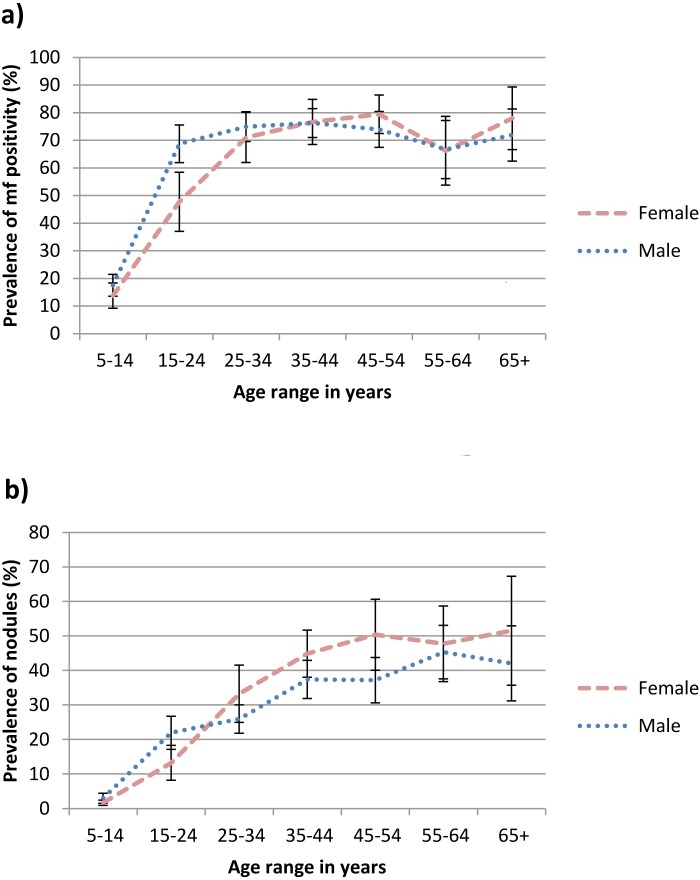
Age and gender-specific prevalence of a) microfilarial positivity and b) nodules in endemic savanna communities, Kaduna State, Northern Nigeria. Error bars represent mean and 95% CI.